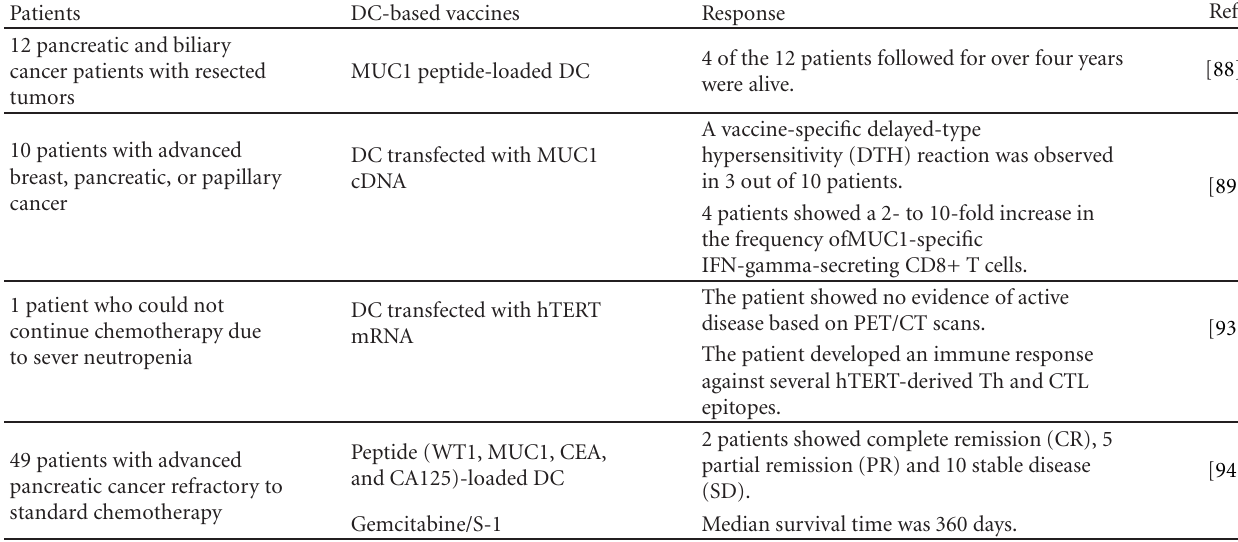
Figure 4: Strategies to deliver defined or whole antigens to DCs. DCs used for cancer vaccines have been generated from the peripheral blood monocytes of the patients using cytokines including GM-CSF and IL-4. To generate antigen-specific CTL response against tumor cells, DCs have been loaded with defined or whole tumor-associated antigens. For example, DCs loaded with synthetic peptide, antigenic DNA, or RNA have been used. Moreover, whole tumor-associated antigens including defined and unidentified have been also loaded to DCs. Table 3: DC-based